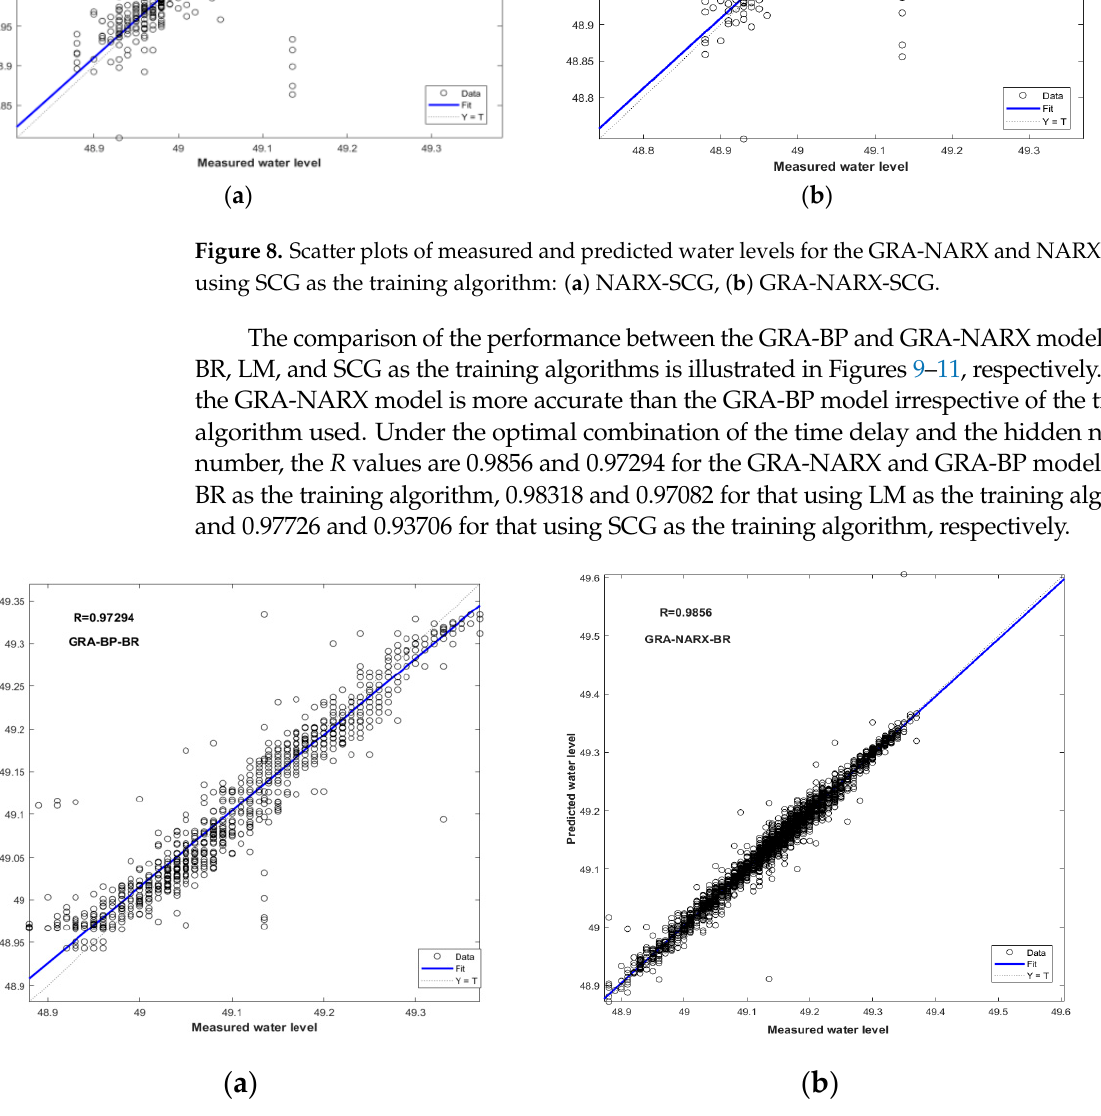
Figure 9. Scatter plots of measured and predicted water levels for the GRA-NARX and GRA-BP